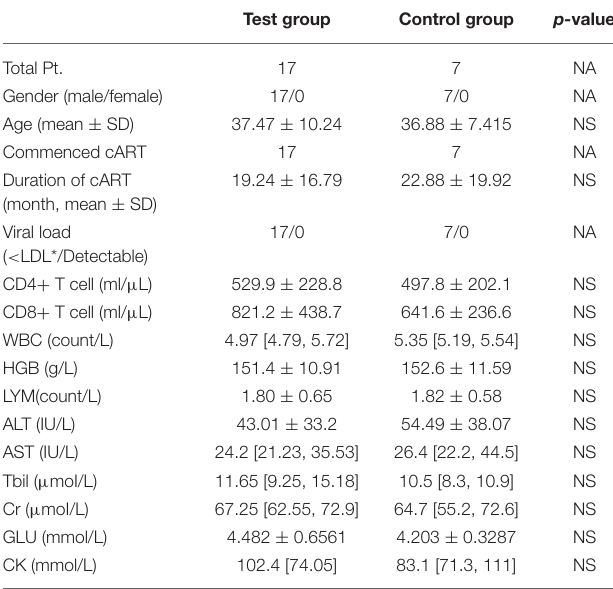
TABLE 2 | Clinical profile of the participants and their baseline data of the two groups. Test group